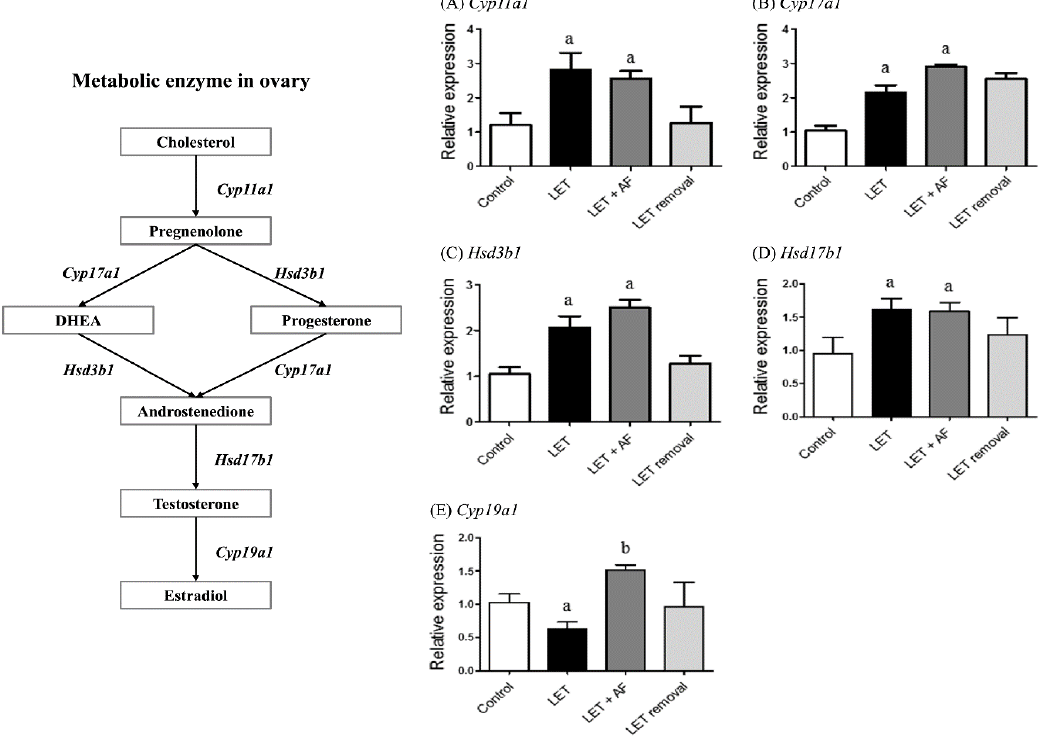
Figure 6. Effect of A. fistulosum root extract on ovarian gene expression related to steroid synthesis in letrozole-induced PCOS rats. Comparison of mRNA expression levels of ( A ) Cyp11a1, ( B ) Cyp17a1, ( C ) Hsd3b1, ( D ) Hsd17b1 and ( E ) Cyp19a1 from ovaries of each experimental group as assessed by quantitative RT-PCR.; Rplp0 was used as in internal control. Values represent means ± SEM; n =